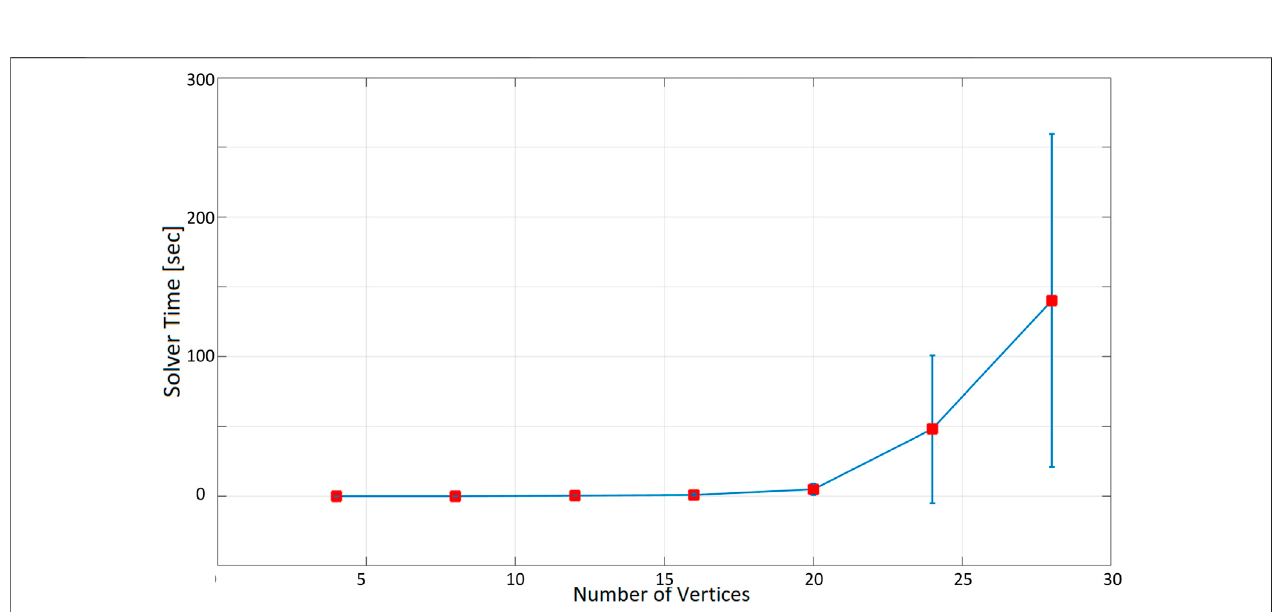
FIGURE 12 | Optimization time (average and standard deviation) versus number of vertices, with the number of targets equal to the number of social charging stations, inspection time spent in targets equal to 300 s.